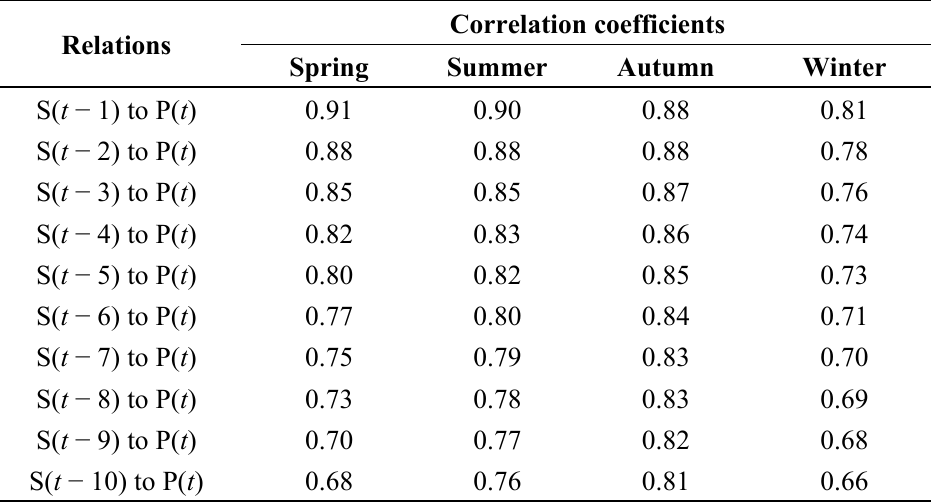
Table 2. Correlation coefficients between wind power and speed time-series ( t is the index for hours).